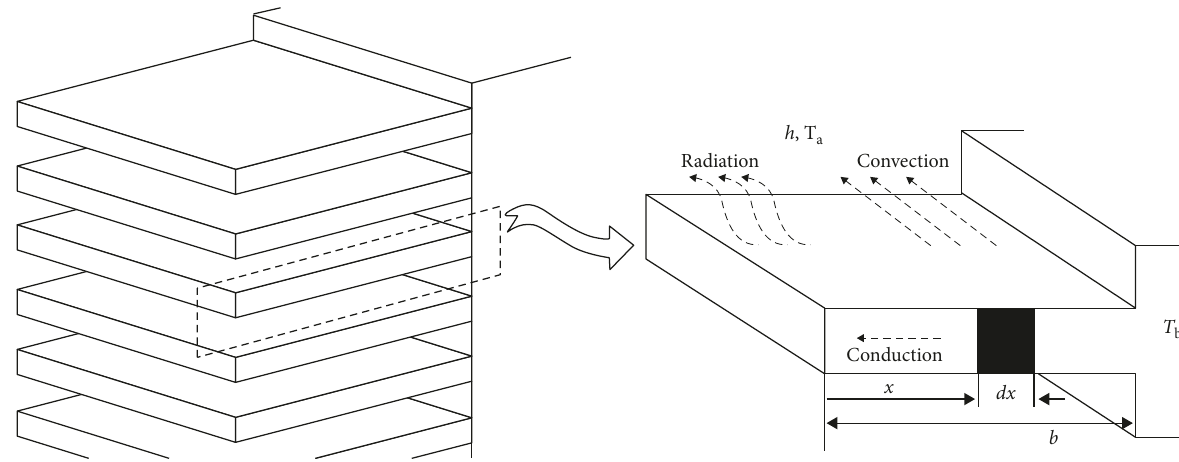
Figure 1: Schematic diagram of heat transfer in a longitudinal fin with